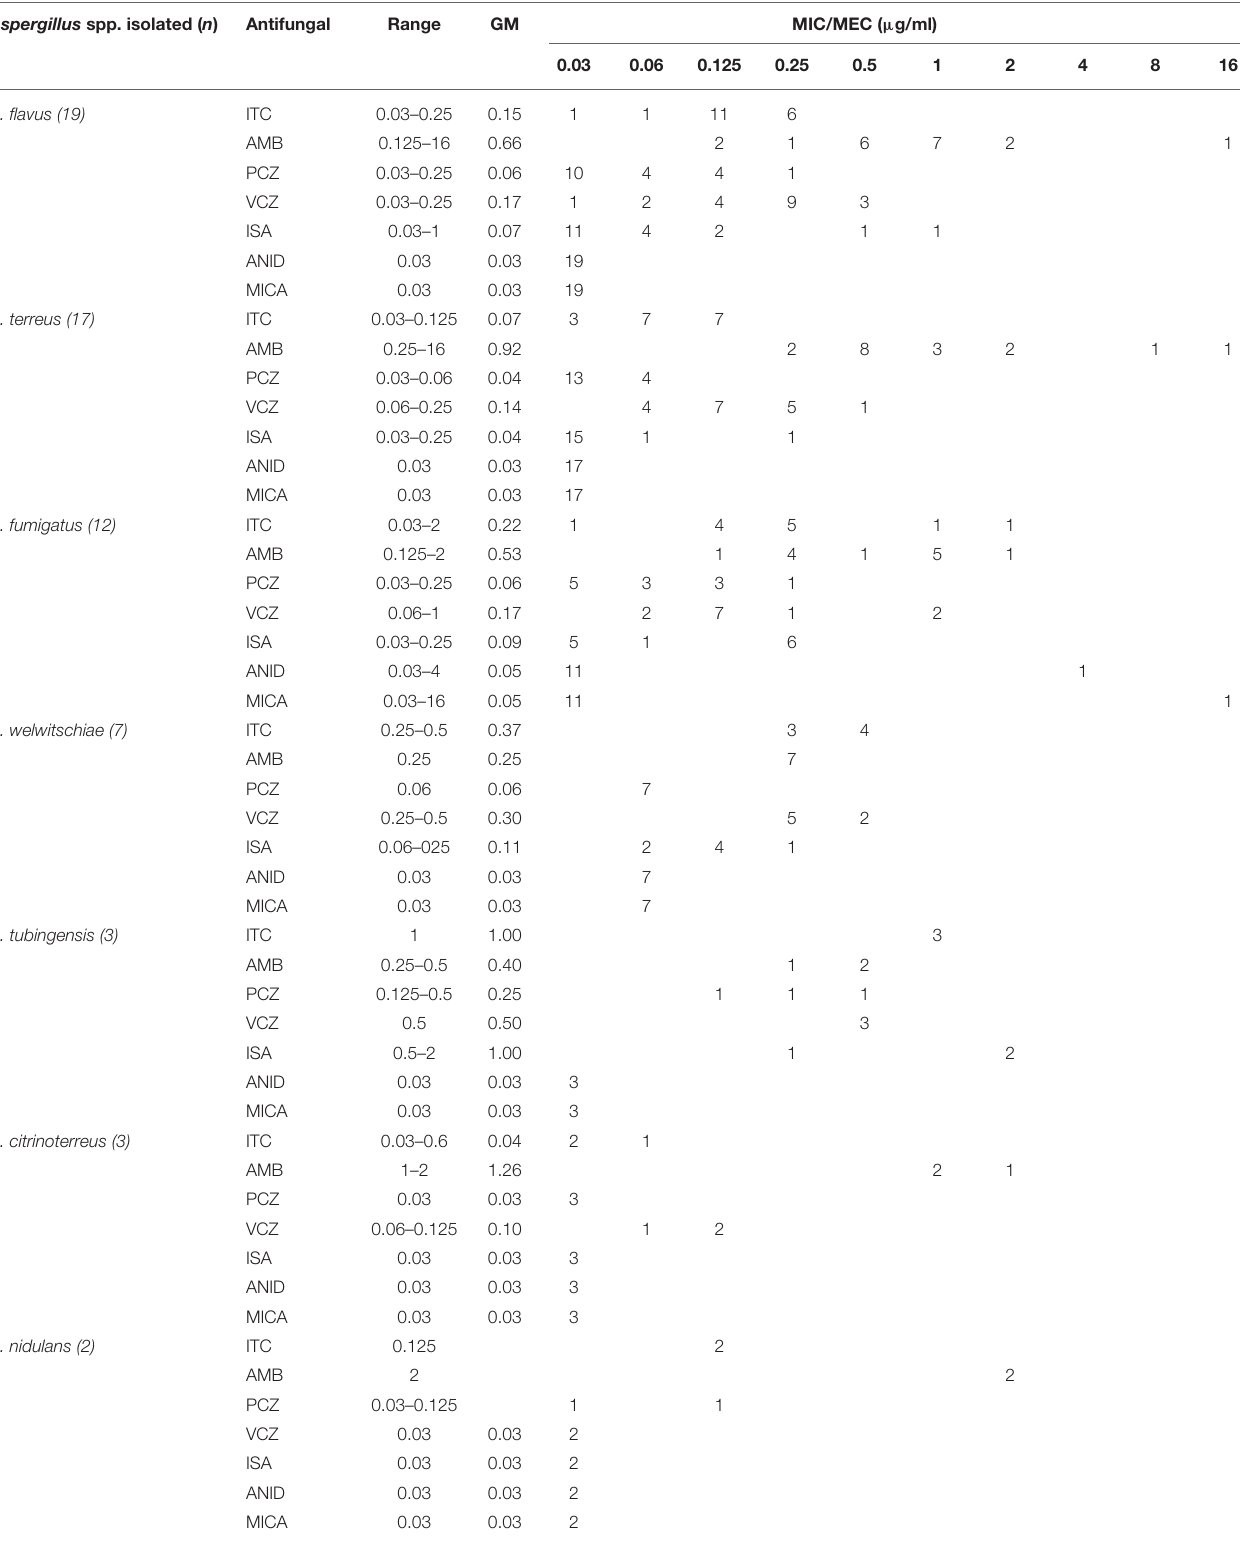
TABLE 4 | In vitro antifungal susceptibility results of Aspergillus spp. Aspergillus spp. isolated ( n